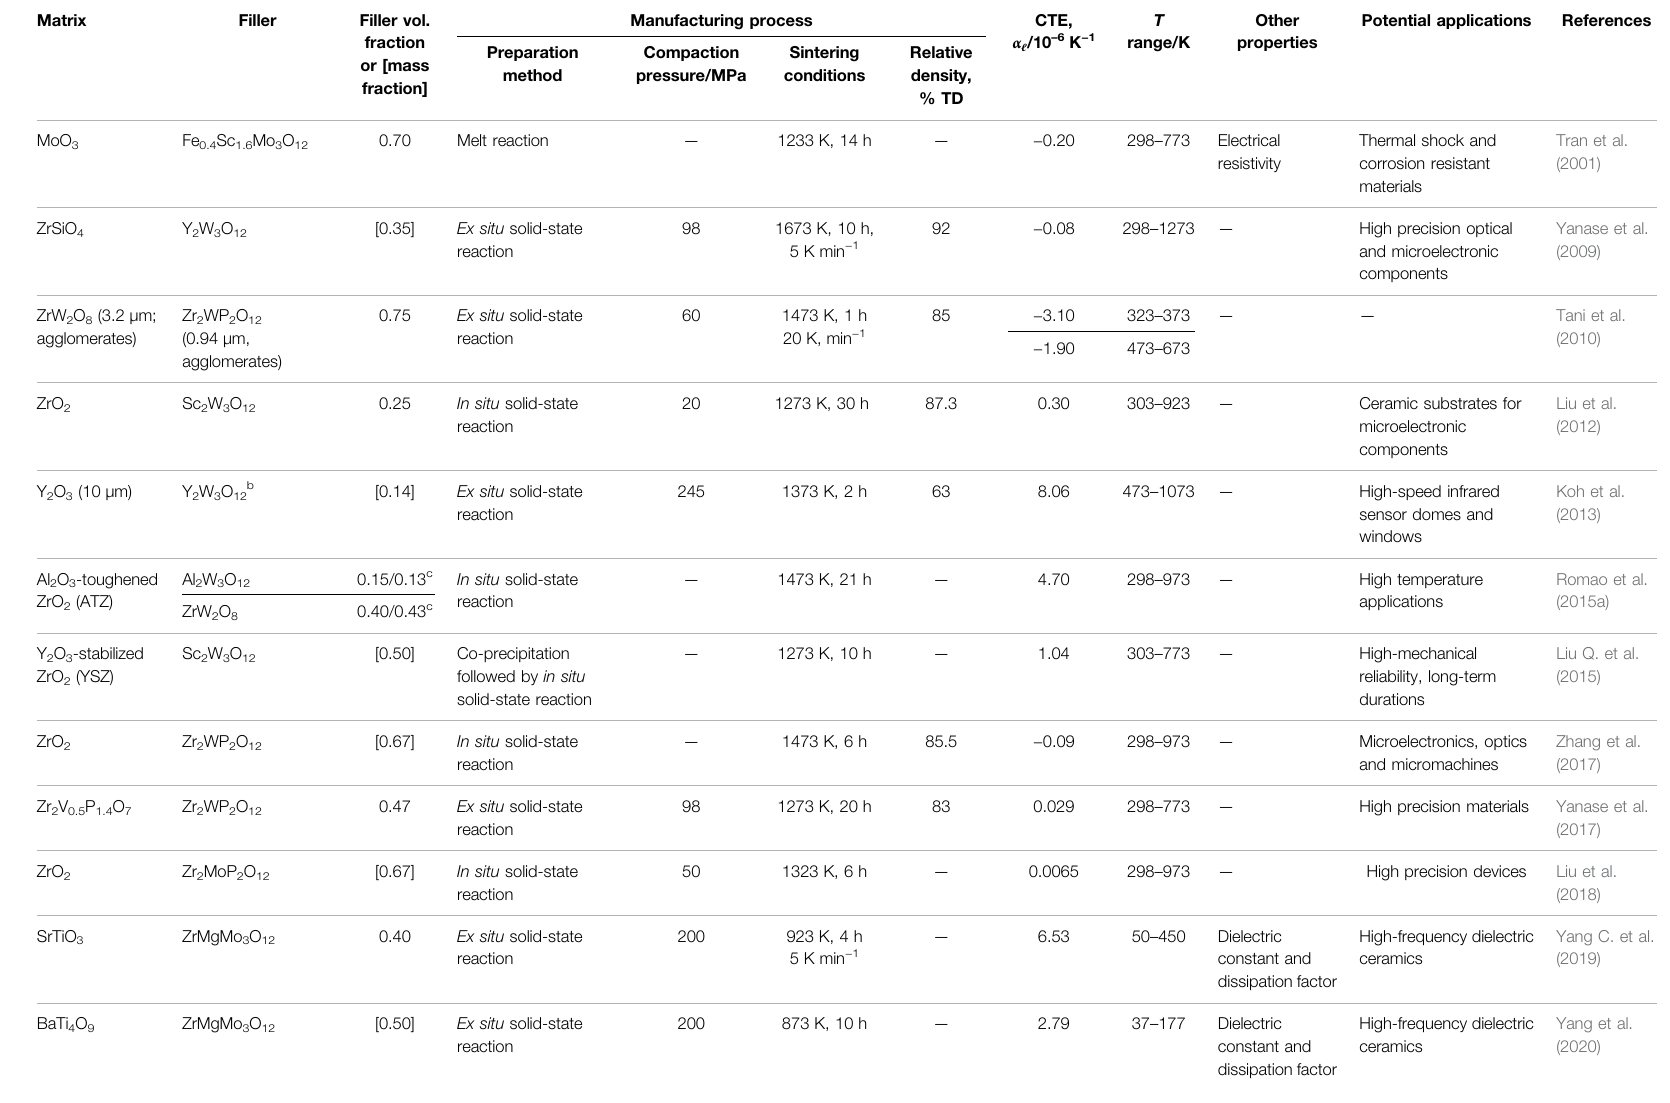
TABLE 1 | Ceramic Matrix Composites (CMCs) fi lled with A 2 M 3 O 12 and related families, their manufacturing conditions, linear CTE and potential applications a .